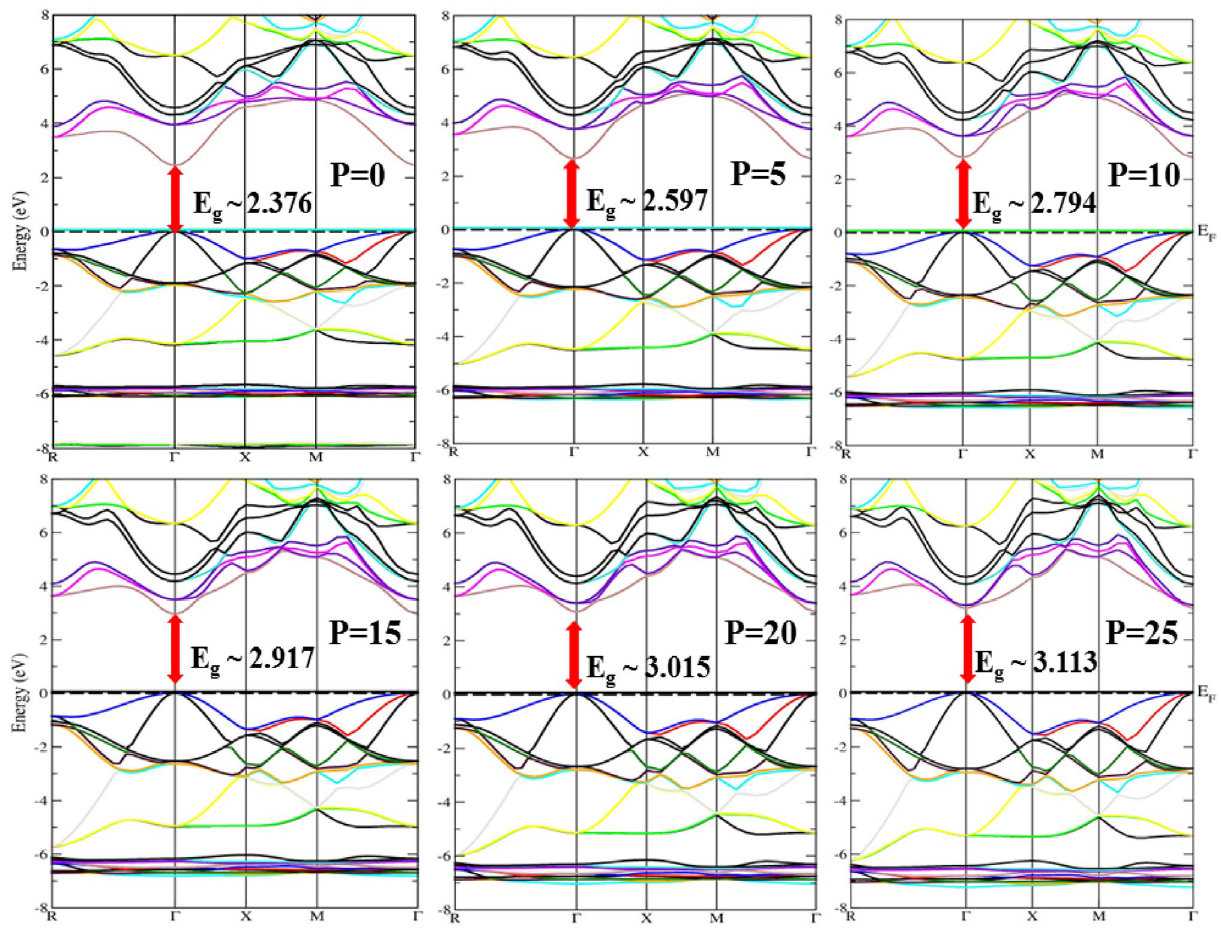
Figure 2. Band structures of the Cd 0.25 Zn 0.75 Se semiconductor under the influence of high pressures approximated within